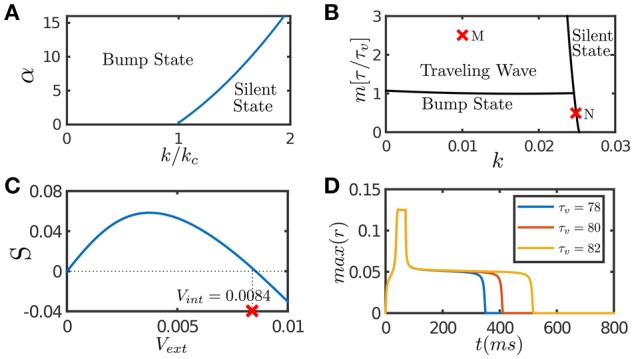
Network dynamics with individual features. (A) The phase diagram of a CANN with only STF included. The graph shows the stationary states of the network with the varying STF strength α and the global inhibition strength k. kc is the critical inhibition strength below which a CANN without STF can hold bump states. STF allows the regime of bump states to expand to k > kc. (B) The phase diagram of a CANN with only SFA included. The network can hold traveling waves if the strength of SFA satisfies m > τ/τv. (C) The tracking performance of a CANN with SFA. An external moving input given by Equation (8) is applied to the network, Aamp = 0.1. S is the separation between the network bump and the external input when tracking reaches to a stationary process. Svext > 0 implies anticipative tracking. The parameters (k, m) = (0.01, 2.5) at the point M in (B), where the network holds traveling waves, is used. vint denotes the speed of the traveling wave the network can hold without relying on external drive. Anticipation occurs when vext < vint. (D) The plateau decay of a CANN with SFA when the network is marginally unstable. The parameters (k, m) = (0.0249, 0.5) at the point N close to the boundary in (B) is used. The lifetime of the plateau increases with the time scale τv of SFA. The simulations were done with a 2D CANN having 100 × 100 neurons uniformly distributed in the space (−π, π] with the periodic condition. Other parameters are J0 = 0.05, a = 0.5, τ = 1 ms.